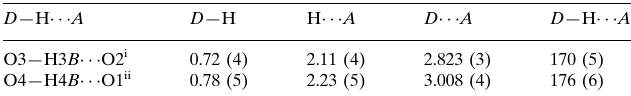
Hydrogen-bond geometry (A˚ , (cid:4)